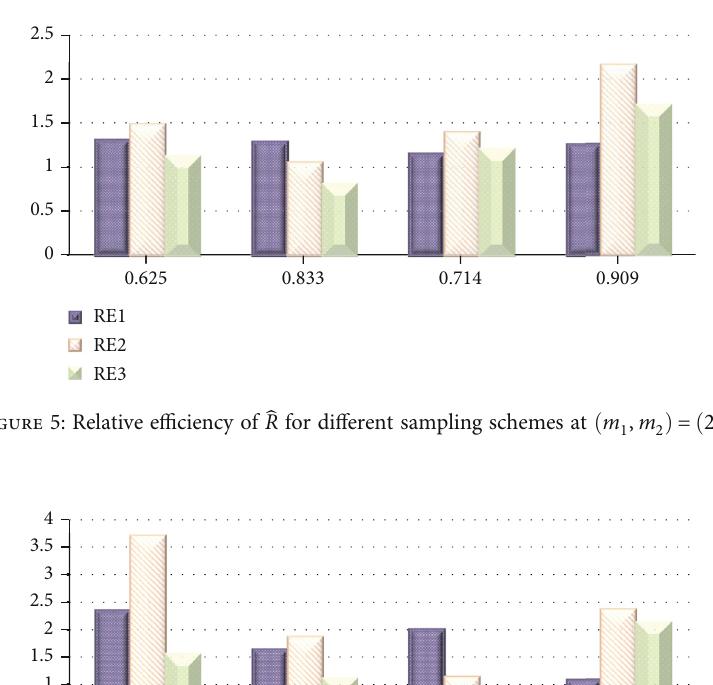
Figure 4: MSE of ̂ R for di ff erent sampling schemes at ð m